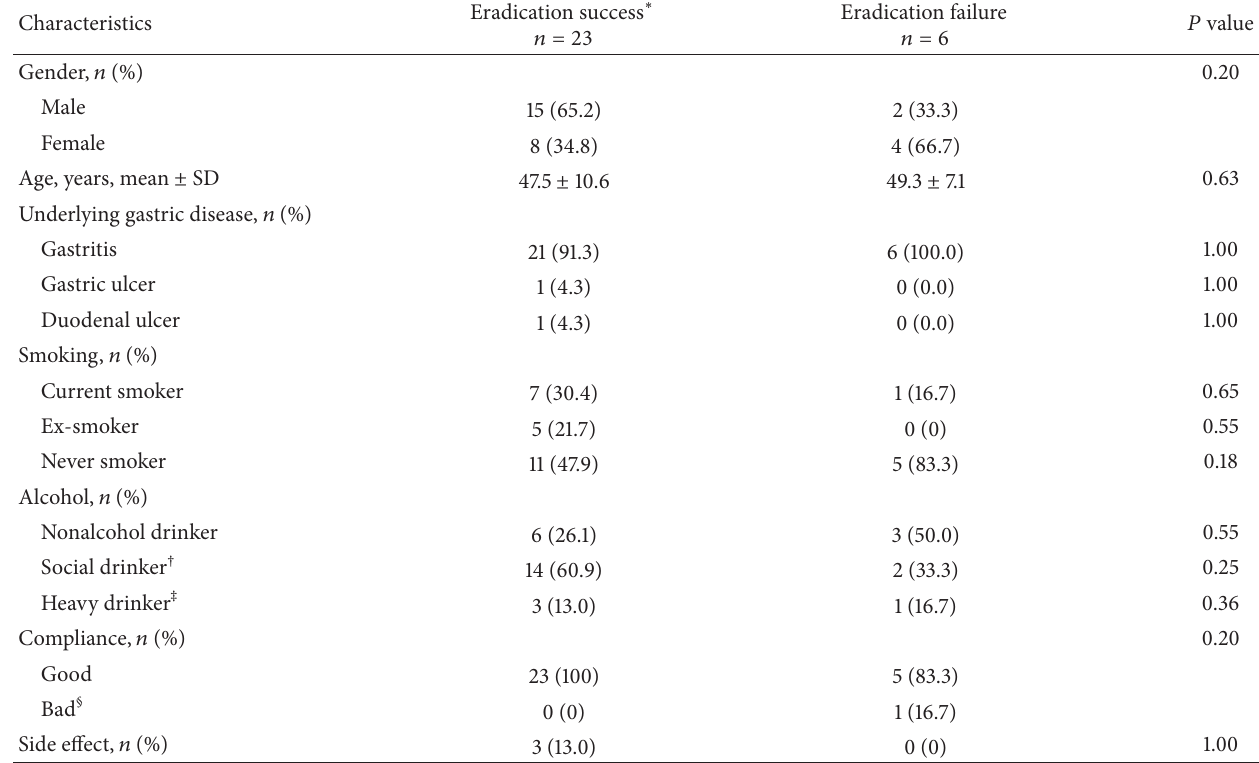
Table 1: Baseline characteristics of the study